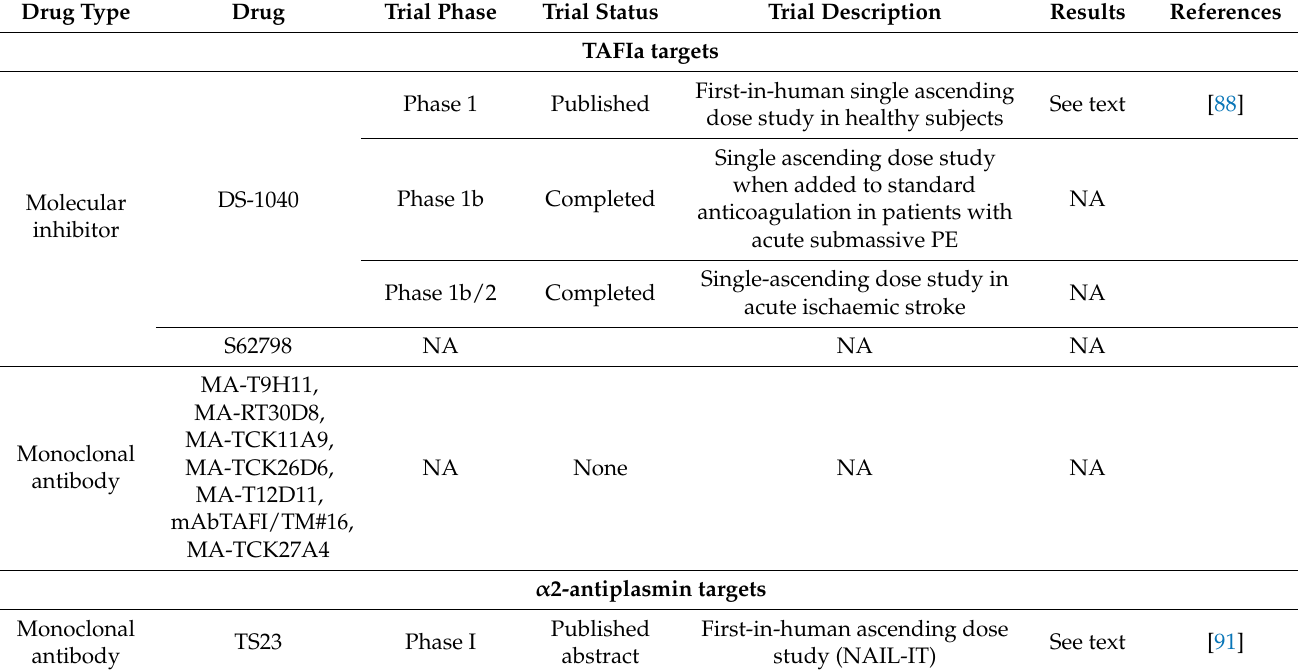
Table 3. Novel fibrinolytic therapies and clinical